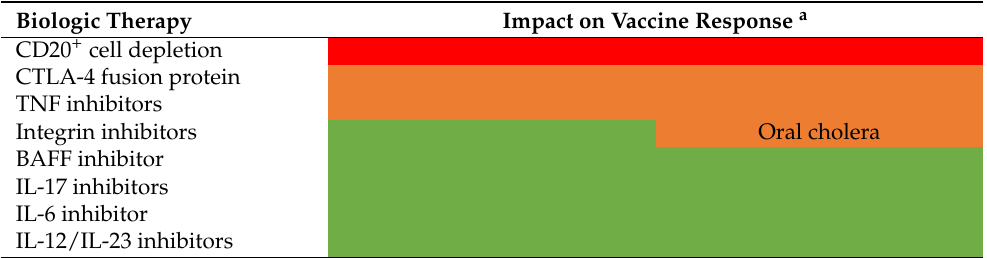
Table 2. Graphical summary on the effect of biologic therapies on response to vaccination in IMID